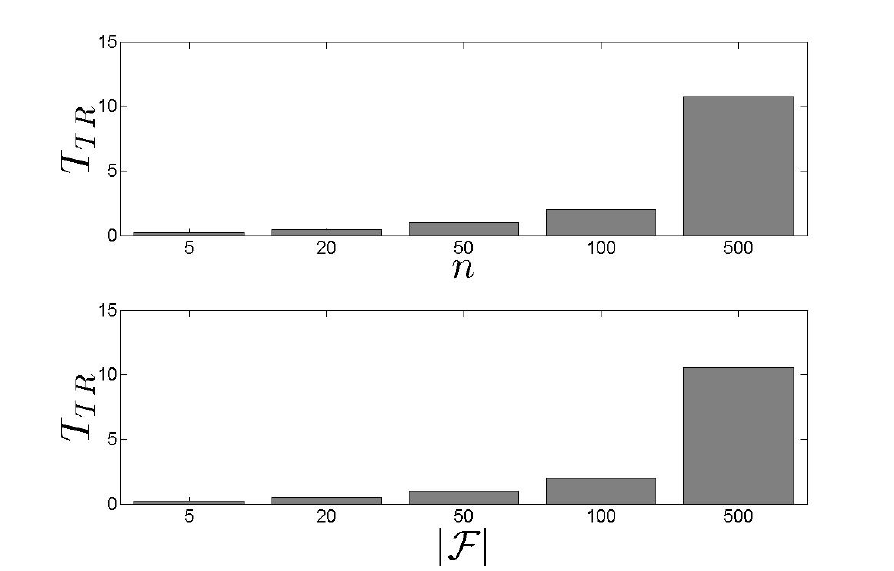
Figure 4. The CS initial set of clusters creation time.